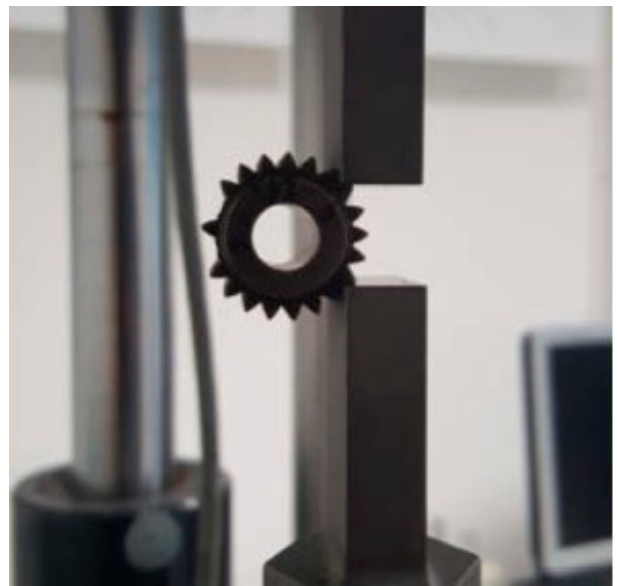
Figure 2. Tooth bending fatigue testing configuration. Detail of the anvils and the gear under testing. Image taken from [26].